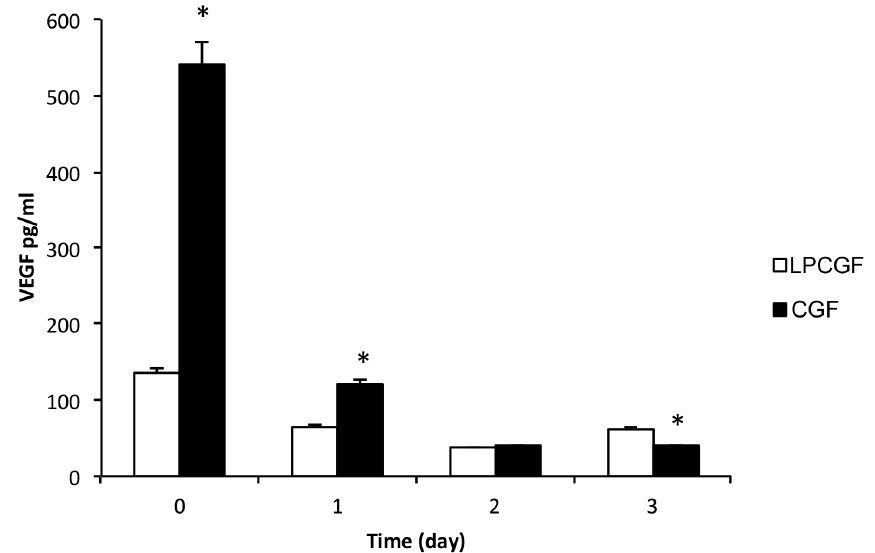
Figure 3. ELISA quantification of human vascular endothelial growth factor (VEGF) into phosphate buffer saline (PBS) from CGF and LPCGF at various times (0–3 days). Values are means ± SD, n = 3. * p < 0.05 denotes the statistically significant differences between VEGF released by CGF or LPCGF.